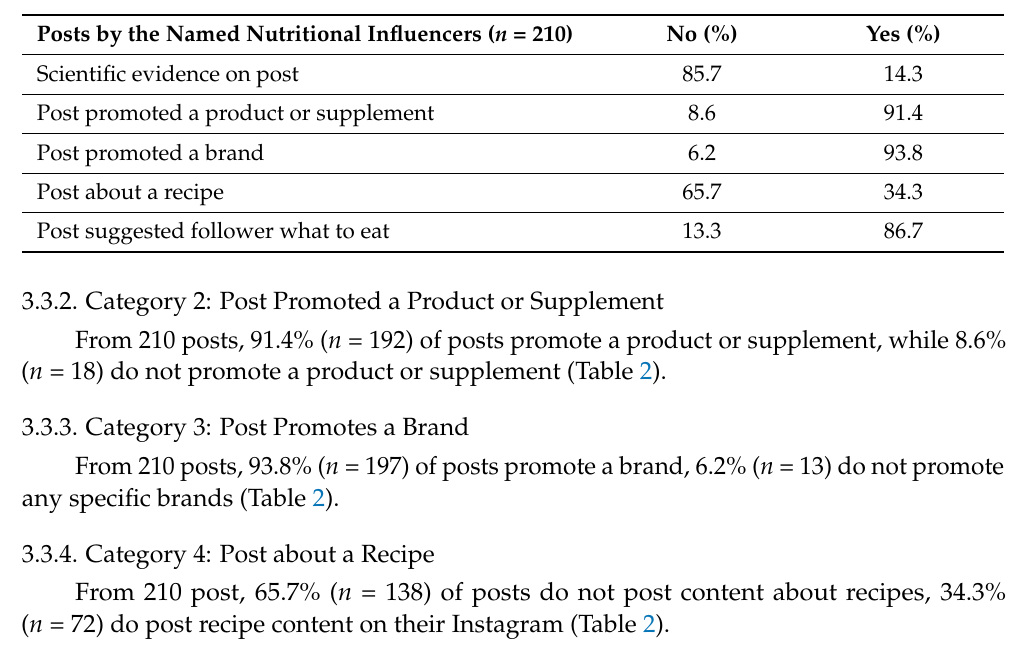
Table 2. Posts by the named nutritional influencers